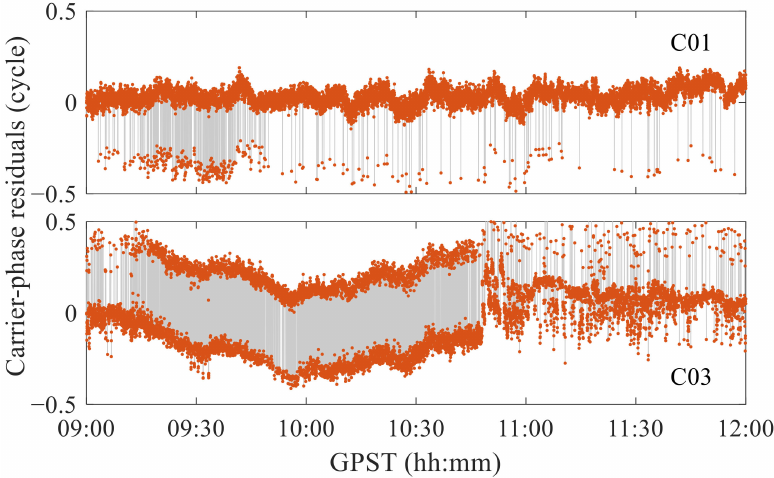
Figure 11. Half-cycle jump of BDS GEO satellite observations acquired by